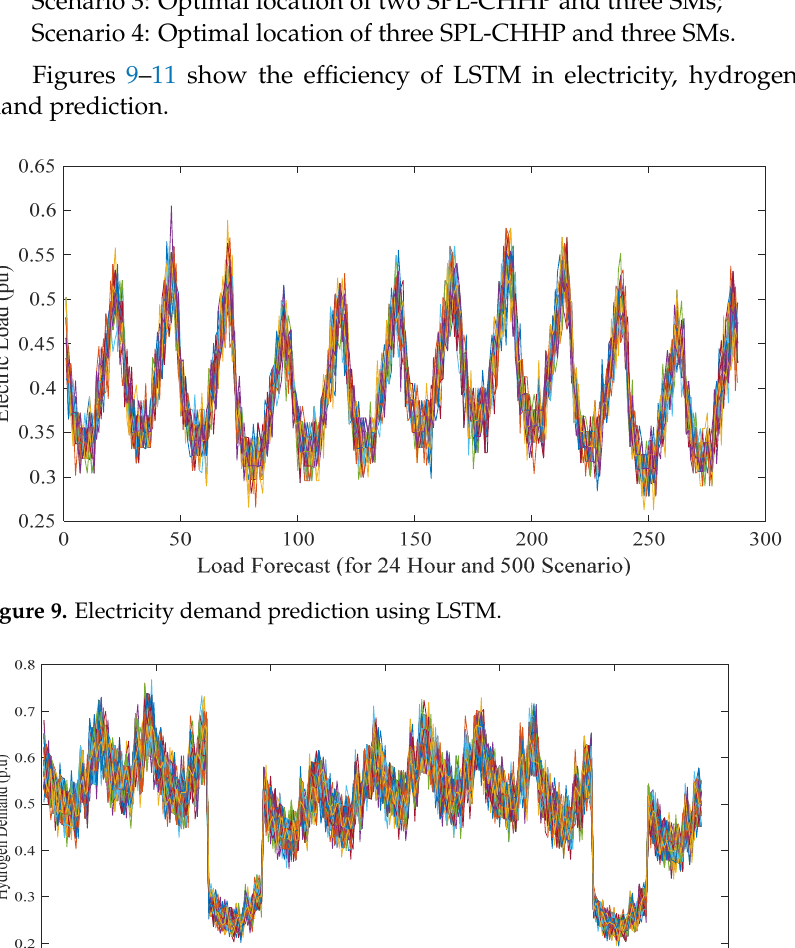
Figure 8. The proposed study system.